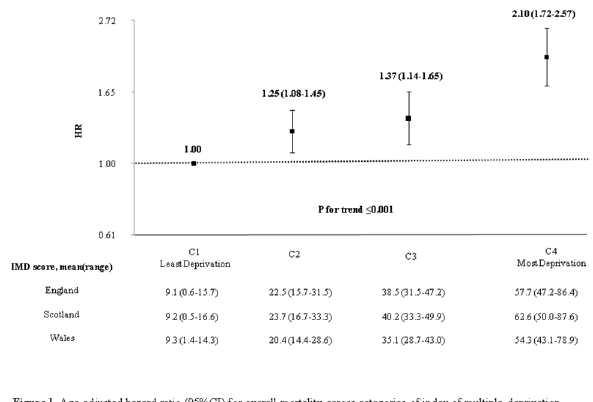
Figure 1. Age-adjusted hazard ratio (95%CI) for overall mortality across categories of index of multiple deprivation. The vertical axis is plotted in the log-scale. The distances between categories in the horizontal axis correspond to the mean values for index of multiple deprivation (IMD) in England. IMD categories were based on the standard deviation (SD) from the overall score from each country (SD by country: England= 15.7, Wales= 14.3 and Scotland= 16.6). Numbers above each box indicate the corresponding hazard ratios and 95% confidence intervals. The mean and the range were calculated from the overall score from each country by IMD categories.